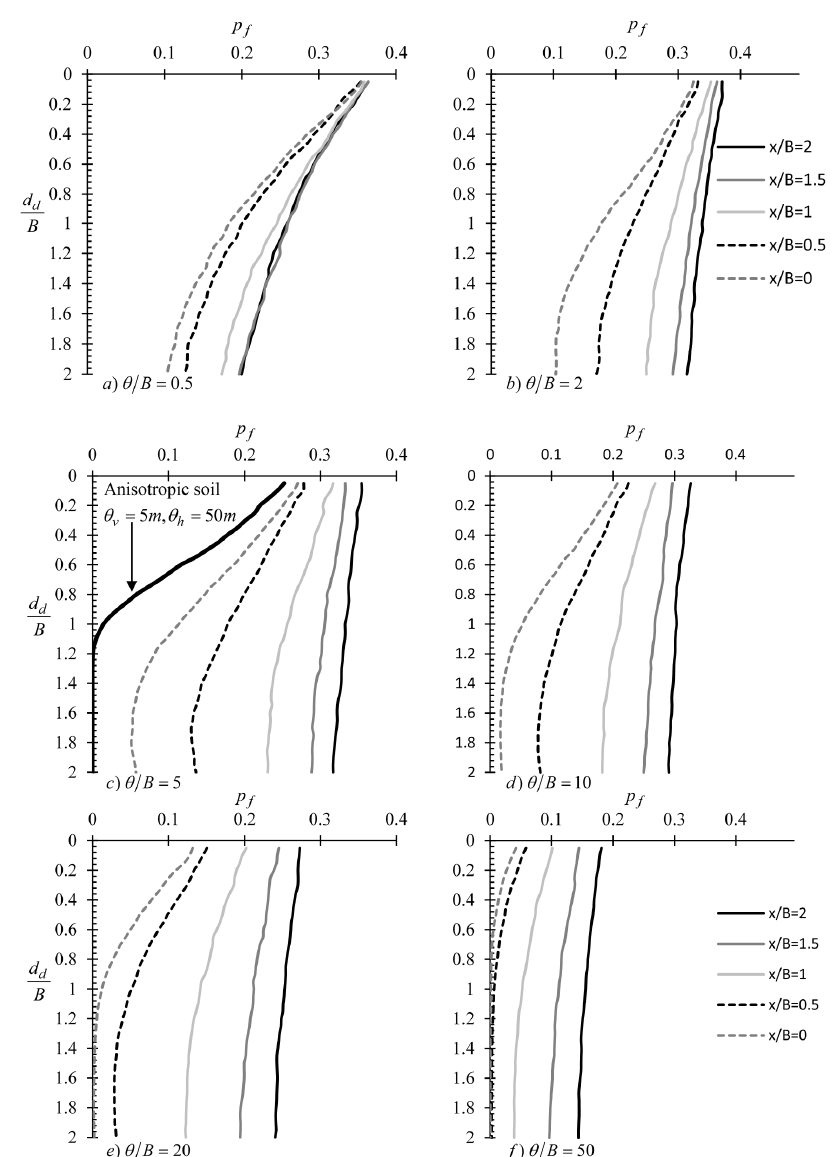
Figure 7. vs. d d / B example curves for various θ / B and x / B values: ( a ) θ / B = 0.5, ( b ) θ / B = 2, ( c ) θ / B Figure 7. vs example curves for various B θ and x B values: ( a ) B θ = 0.5, ( b ) B θ = 2, d d B = 5, ( d ) θ / B = 10, ( e ) θ / B = 20 and ( f ) θ / B = 50. The thick continuous line in ( c ) is for the anisotropic ( c ) B θ = 5, ( d ) B θ = 10, ( e ) B θ = 20 and ( f ) B θ = 50. The thick continuous line in ( c ) is for the case and refers to the x / B = 0 anisotropic case and refers to the x B = 0 case.